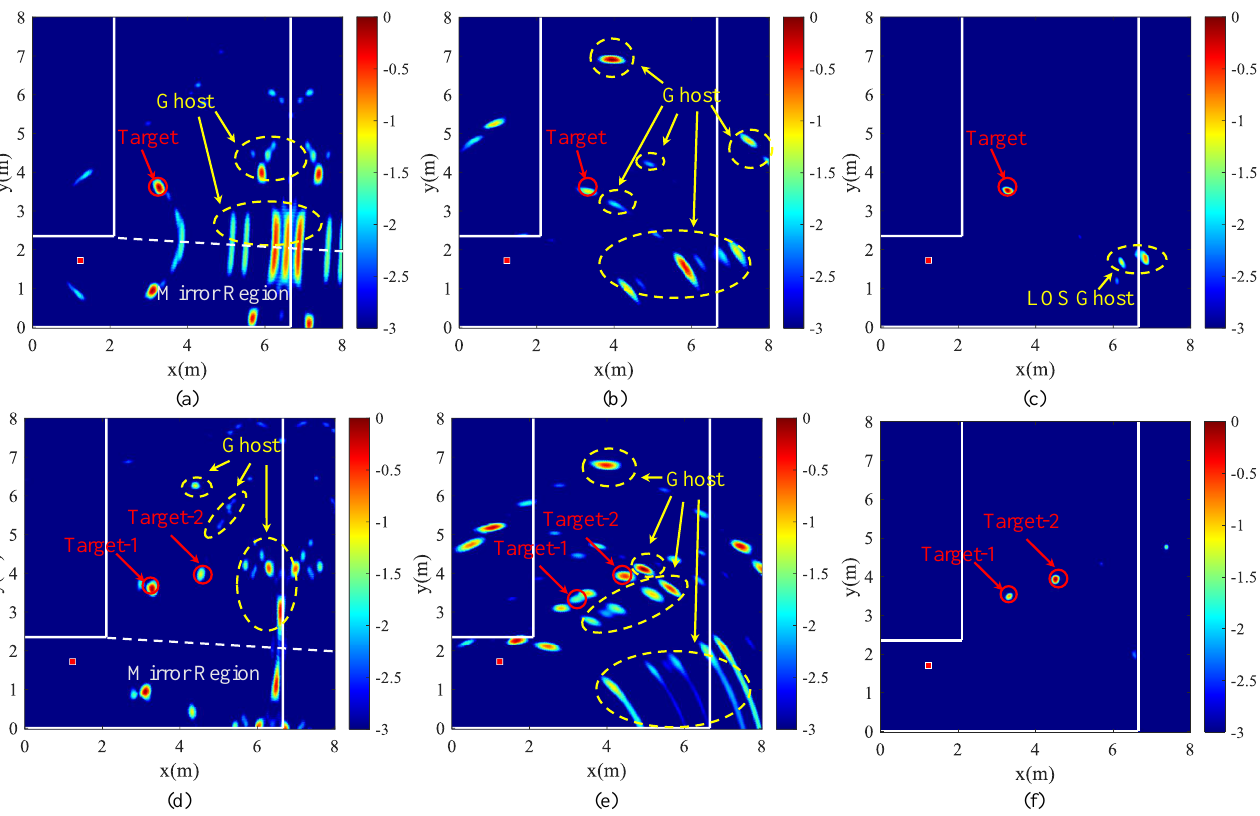
Figure 15. Multipath imaging results after replacing View 2 with View 3 in both single and dou- ble target scenarios. ( a – c ) Imaging result of View 1, View 3 and fusion in single target scenario. ( d – f ) Imaging result of View 1, View 3 and fusion in double target